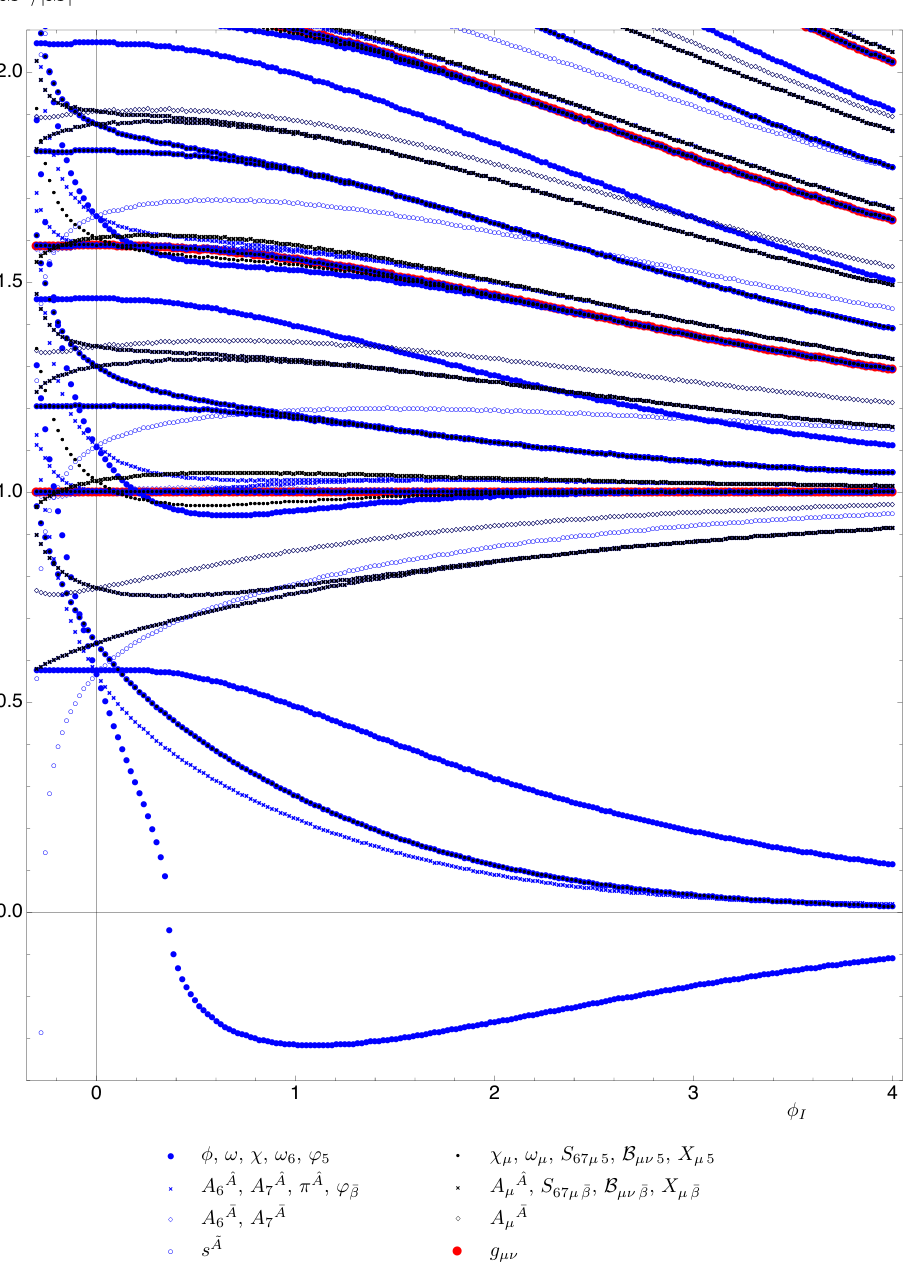
Figure 7 . Detail of the combined mass spectrum M 2 = − q 2 of all the bosons, as a function of the parameter φ , normalised to the lightest tensor mode, and restricted to the low-mass region. In I red we depict the spin-2 particles, in black the spin-1, in blue the spin-0. The markers are chosen to match the representations under SO(4) , while the legend refers back to the notation in table 1. Numerical calculations use ρ = 10 − 10 and ρ = 10 1 2